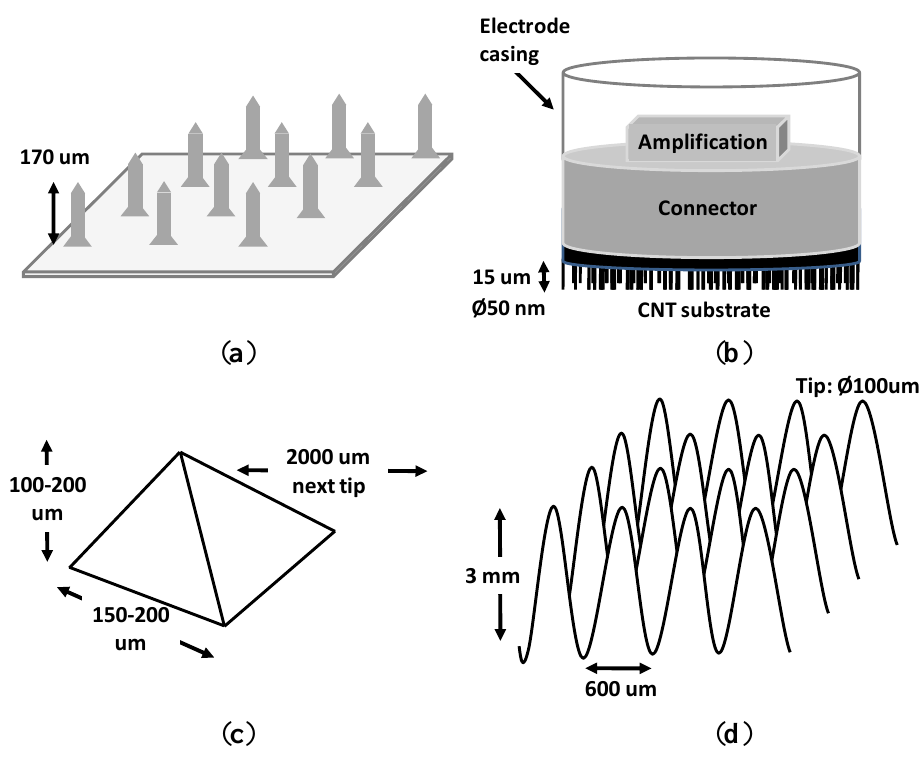
Figure 2. ( a ) Array of silicon microneedles. Adapted from [8]; ( b ) Multiwalled carbon nanotube arrays. Adapted from [11]; ( c ) Details of a microtip. Adapted from [12]; ( d ) 3D printed dry millielectrode. Adapted from